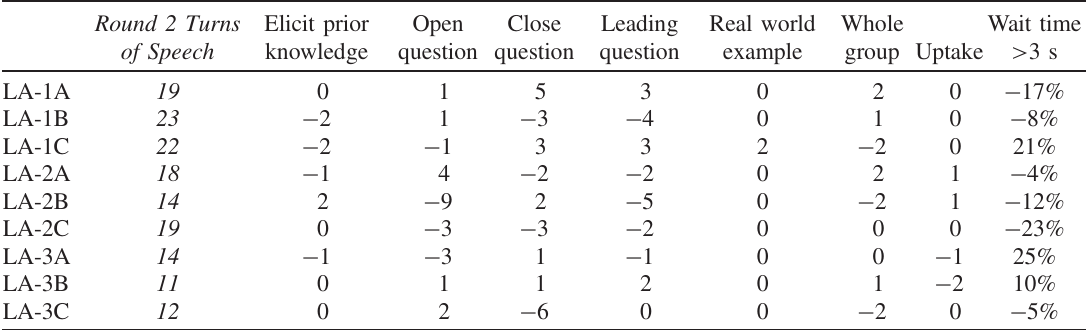
TABLE IV. Shifts in pedagogical skill use from round 1 to round 2.